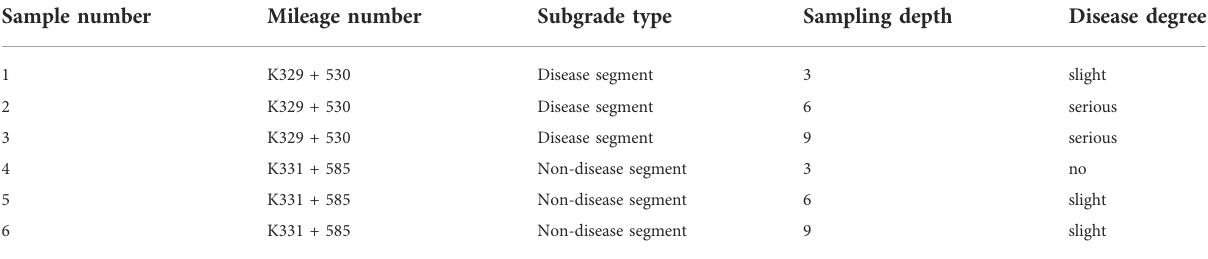
TABLE 1 The basic situation of the sample. Sample number